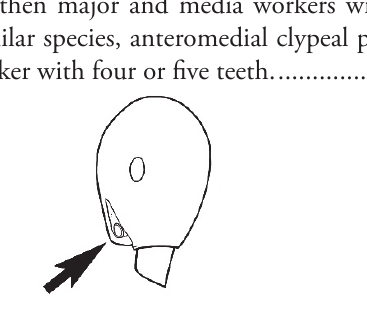
89 Palps extremely short and variable in appearance and number of segments, palps when directed posteriad not reaching the hypostomal border, PF 4,3 or 3,3 or even apparently 2,3 (in undissected major worker) (interior SA)